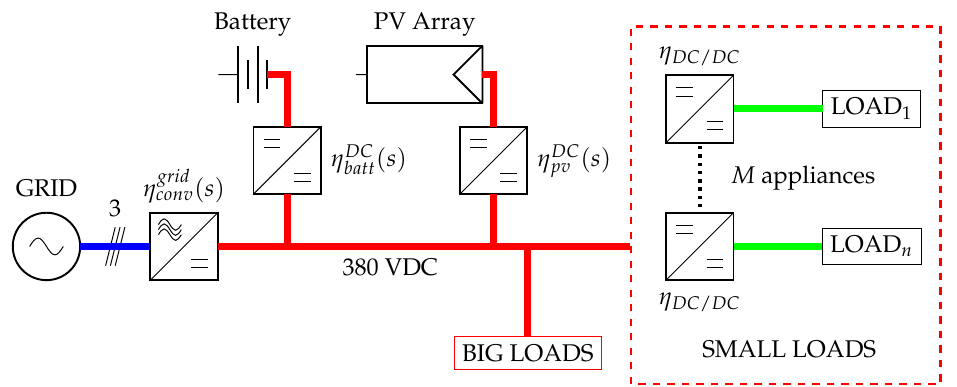
Figure 2. Daily load demand and PV generation from the residential building.